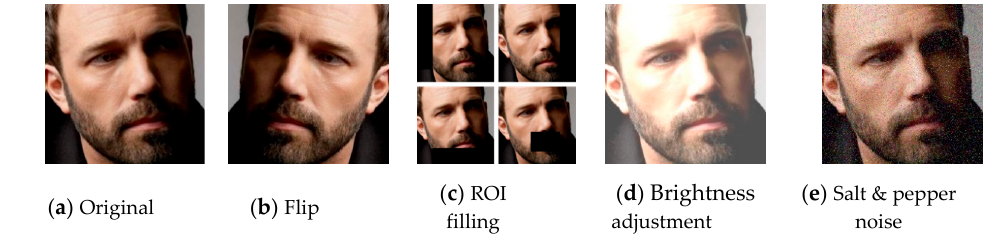
Figure 6. Image augmentation results.